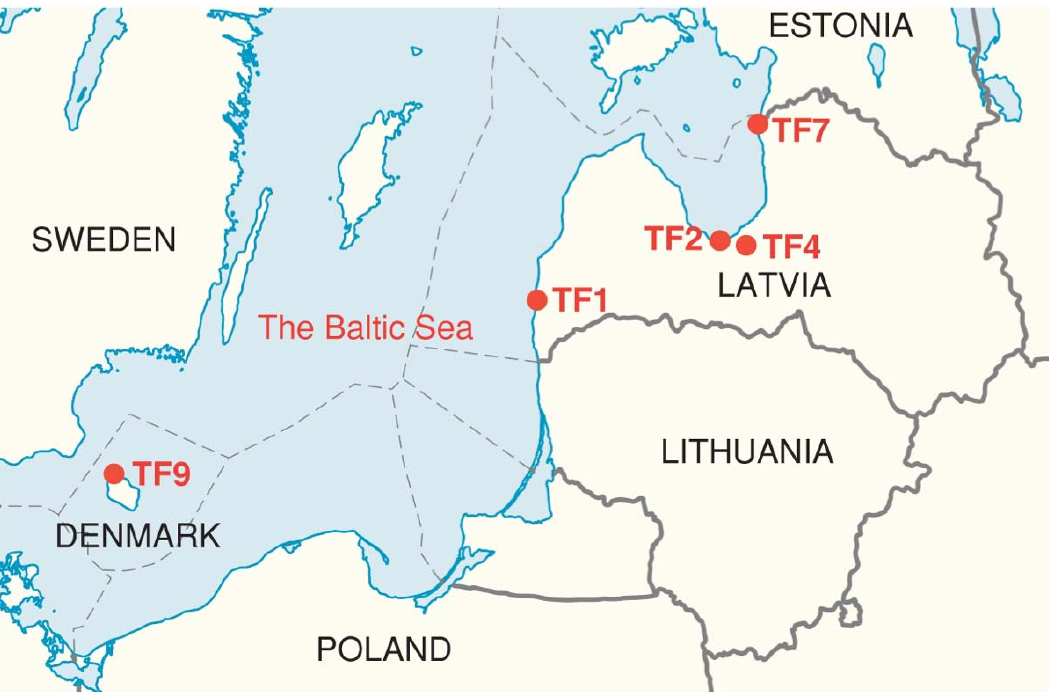
Figure 12. Map of the southern and central Baltic Sea region with Trifolium fragiferum accessions used in the present study.